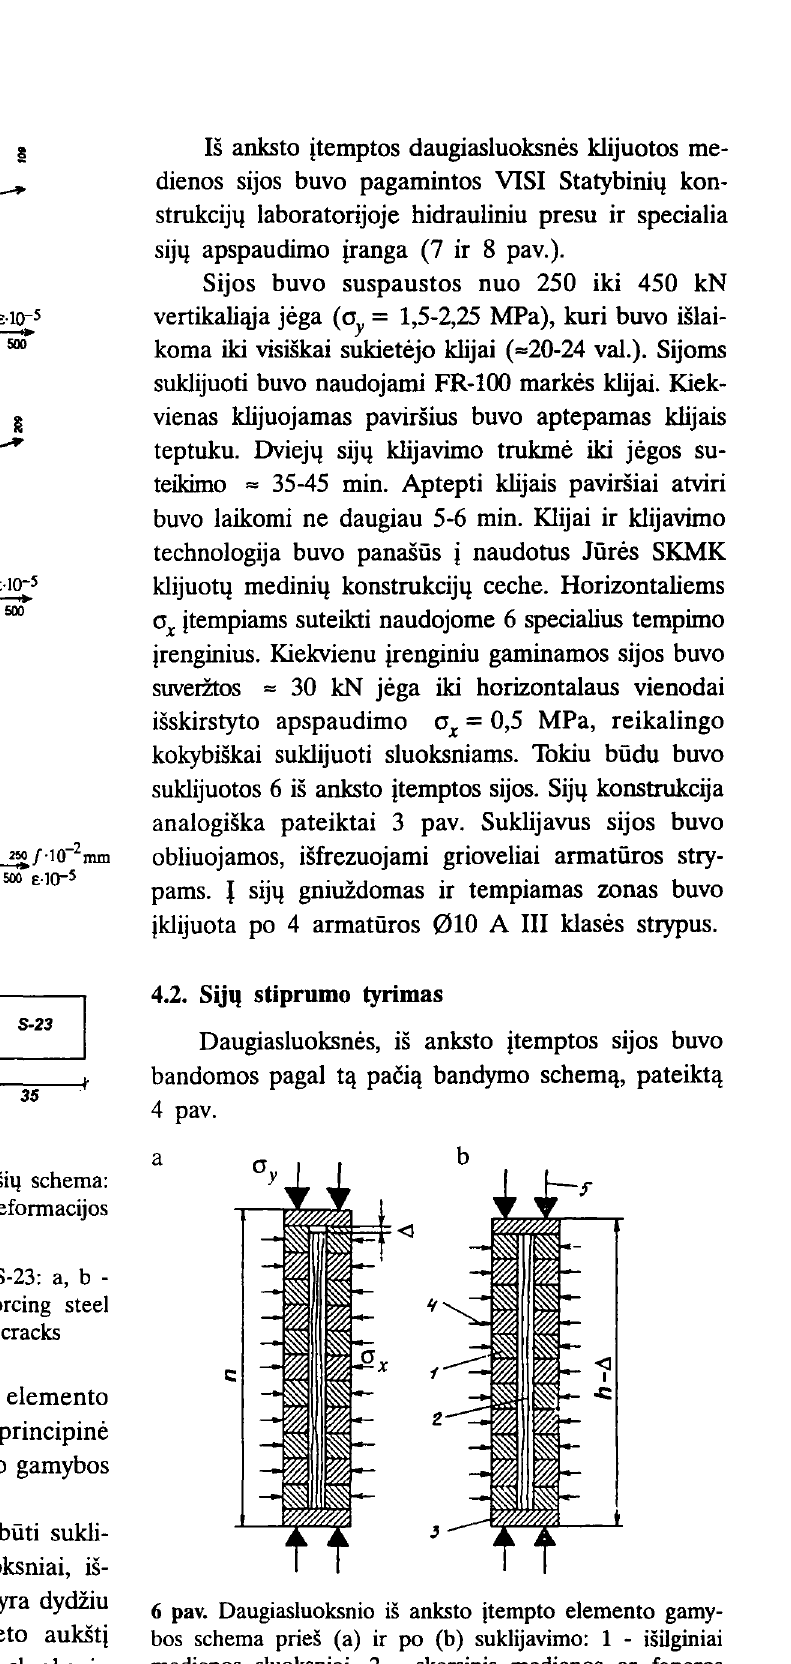
Fig 6. Manufacturing scheme of multilayered prestressed beams before (a) and during (b) gluing: 1 - longitudinal wood layers, 2 - lateral wood layers or plywood, 3 - pro tection board, 4 - horizontal